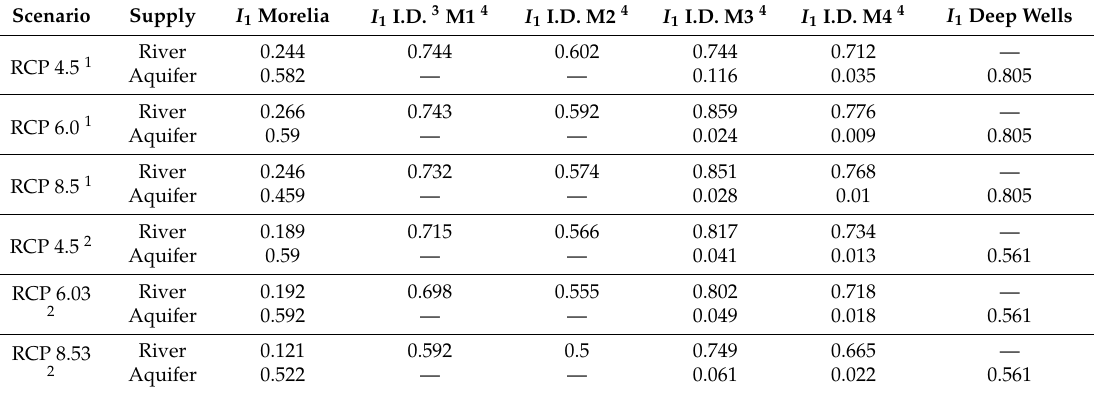
Table 6. Index I 1 of the scenarios with respect to the current supply and demand, including climate change.